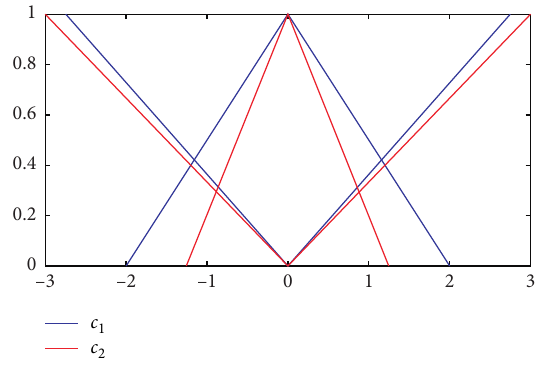
Figure 4: c � (− 2 , 0 , 2 ; − 2 . 75 , 0 , 2 . 75 ) and c 1